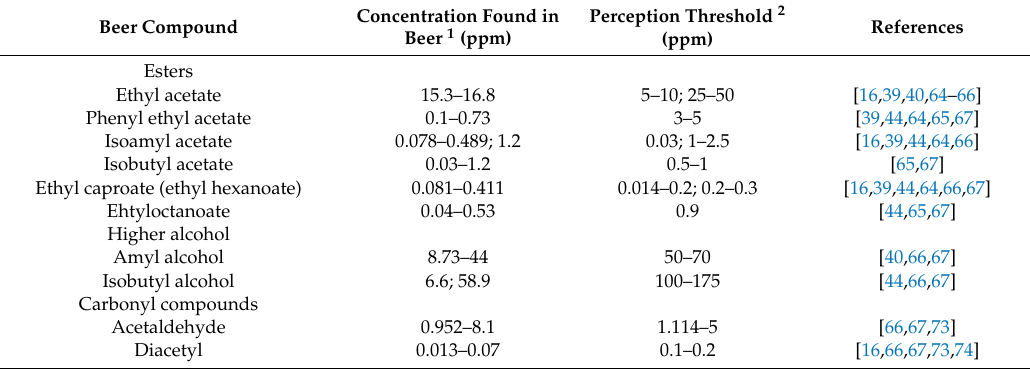
Table 1. Beer flavor compounds in beer and their perception threshold well described in the literature. Beer